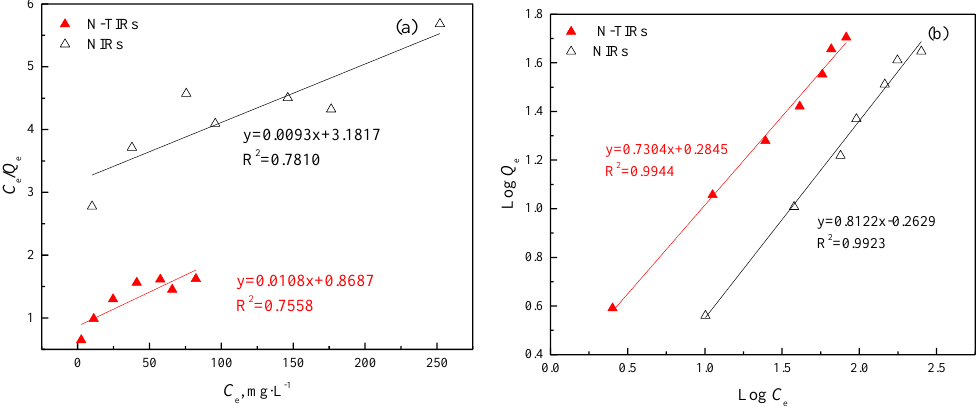
Figure 7. Langmuir ( a ) and Freundlich ( b ) isotherm for V(V) adsorption onto N-TIRs and NIRs. Table 2. Parameters of the Langmuir and Freundlich isotherm models for V(V) adsorption. Langmuir Freundlich SIRs